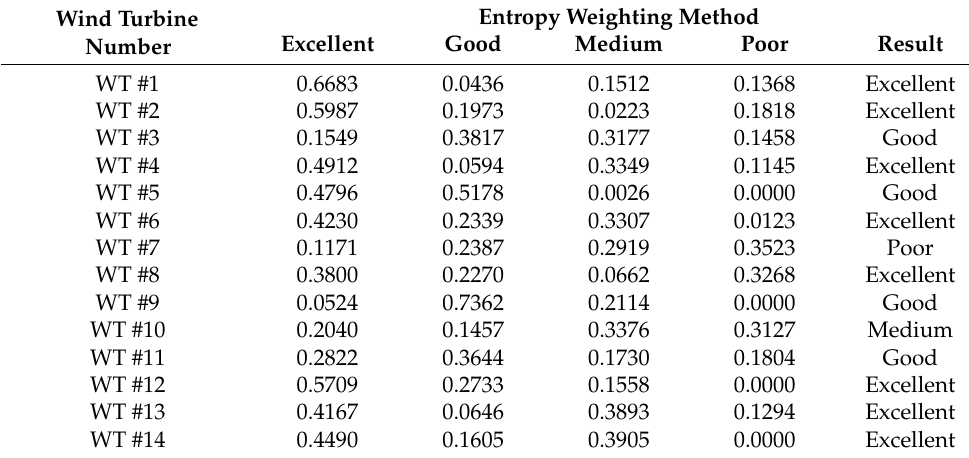
Table 4. The comprehensive evaluation results of wind turbines power generation performance (entropy weighting method).